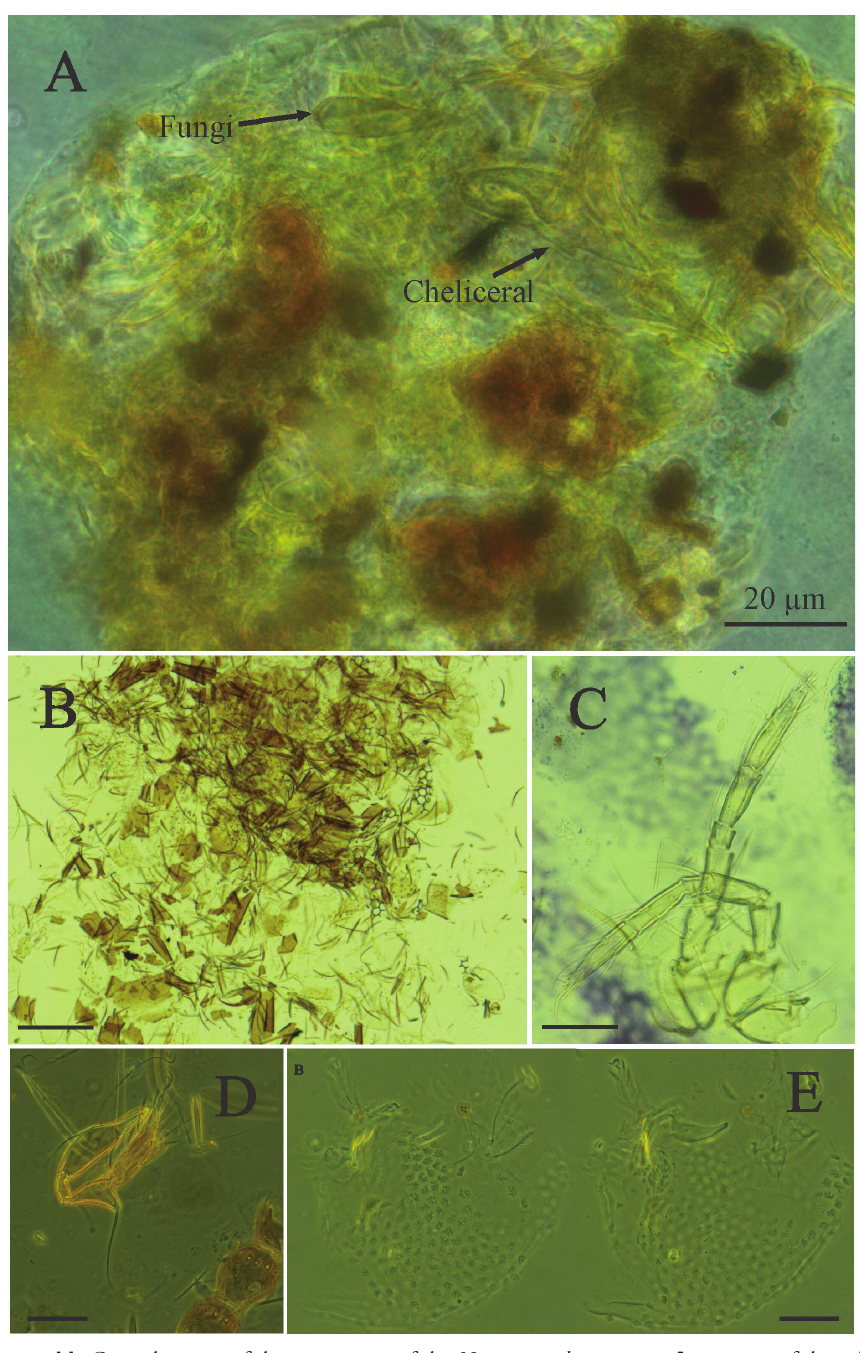
Figure 11. General aspects of the gut content of the Neoacrus spelaion sp. n.: A overview of the pellet with indigested food B plant tissue fragments and C mite part (Parasitengonina larvae) D Oribatida leg E Alycidae